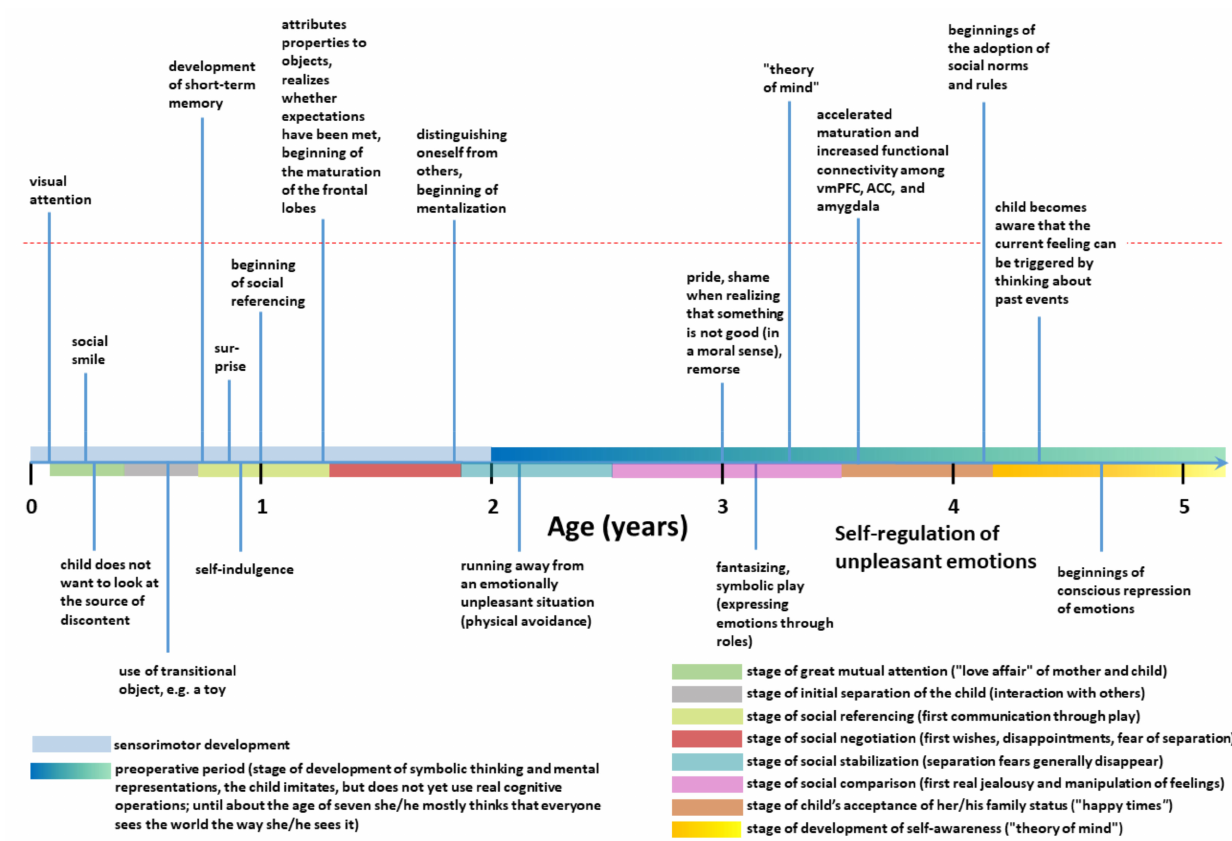
Figure 12. Schematic representation of the development of select emotional and cognitive abilities in children. ACC— anterior cingulate cortex; vmPFC—ventromedial prefrontal cortex. The part of the schematic related to the stages of development is made according to Lewis and Granic (2010)